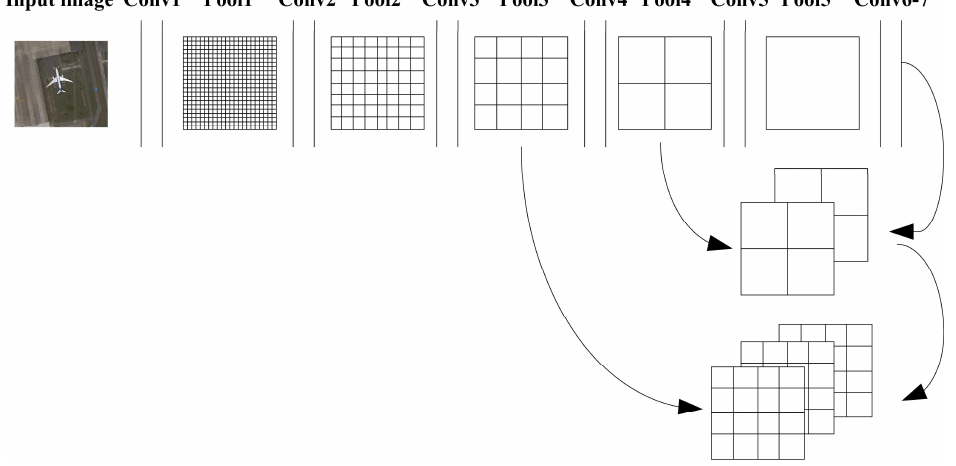
Figure 5. The structure of a fully convolutional network (FCN).